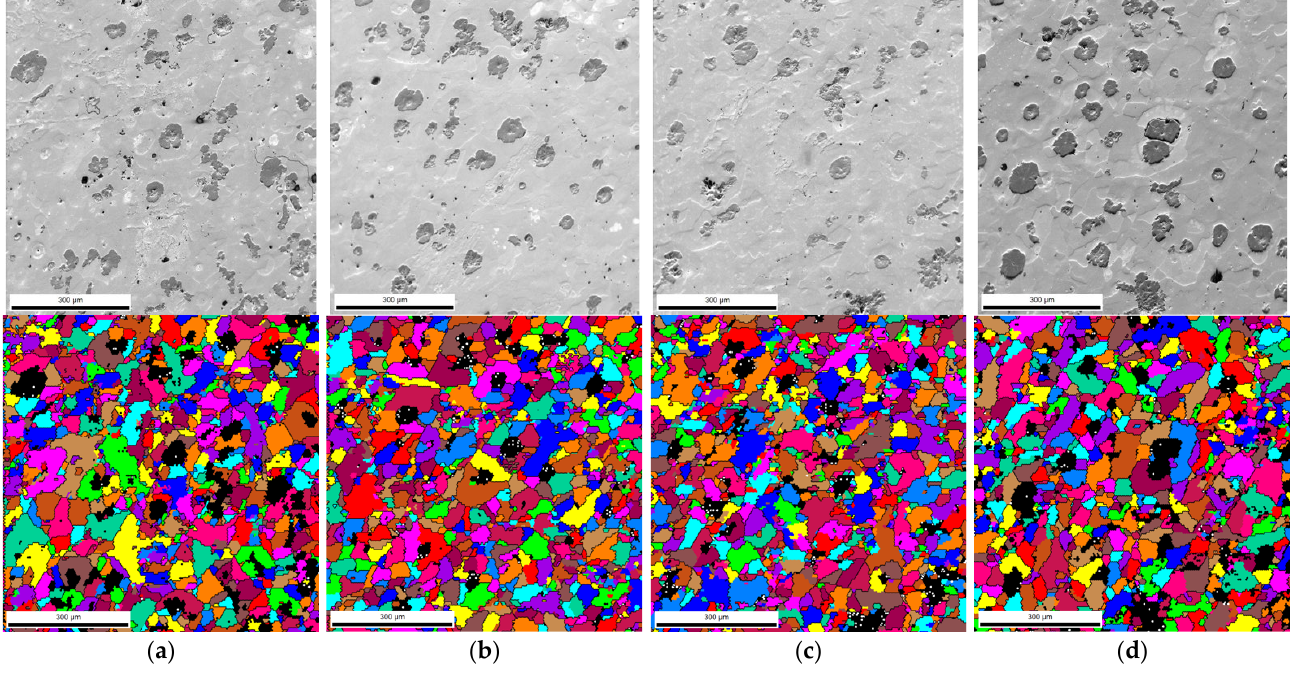
Un , ( b ) CP Un , ( c ) LCP Un , and ( d ) TP Un